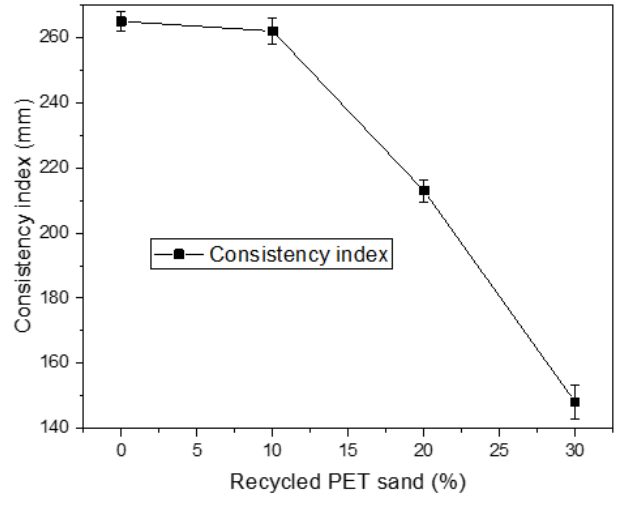
Figure 2. Consistency Index Results.